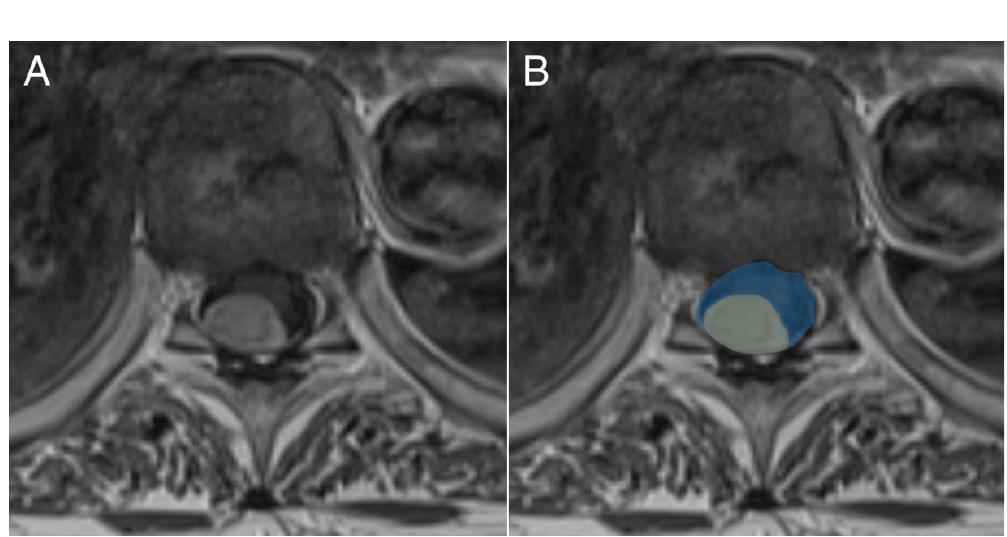
Figure 1. Illustration depicting how cross-sectional tumor area (yellow) and spinal canal area (blue) were calculated from preoperative magnetic resonance images (MRI). ( A ) shows the original MRI, and ( B ) shows the annotation of the tumor and spinal canal area.